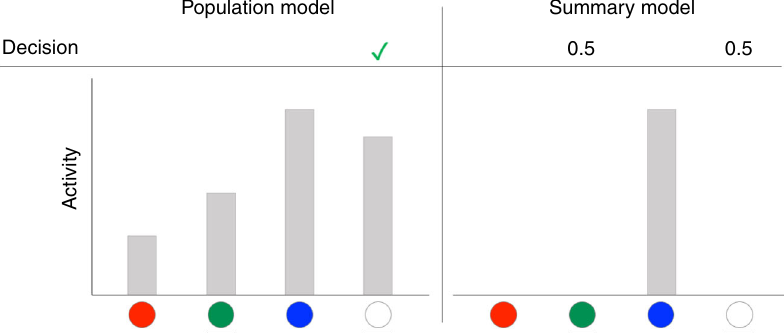
Fig. 3 Predictions of the two models for choices in the two-alternative condition. The population model (left panels) assumes that decision-making circuits have access to the activity levels associated with each of the four colors (four gray bars), whereas the summary model (right panels) assumes that decision-making circuits only have access to the highest activity level (single gray bar). In all examples, the dominant circle is white, and subjects are given a choice between white and green. a When the highest activity happens to be at the dominant color, both models predict that the subject would correctly choose the dominant color. b When the highest activity happens to be at the alternative color, both models predict that the subject would incorrectly choose the alternative color. c The predictions of the two models diverge when the highest activity is associated with a color other than the two presented alternatives. In such cases, the activation for the dominant color is likely to be higher than for the alternative color, so according to the population model, subjects would ignore the color with the highest activity (blue color in the example here) and correctly pick the dominant color in the majority of the trials. However, according to the summary model, subjects have no information about the activation levels for the dominant and the alternative colors and would thus correctly pick the dominant color on only 50% of such